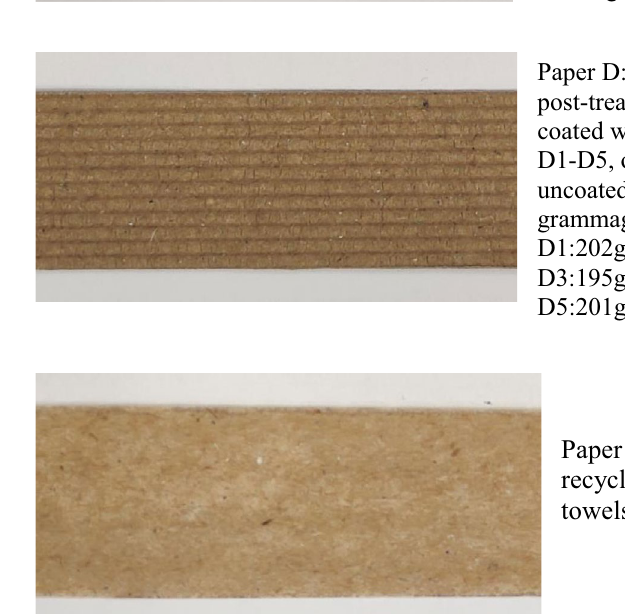
Fig. 17 15 mm wide sample of paper D